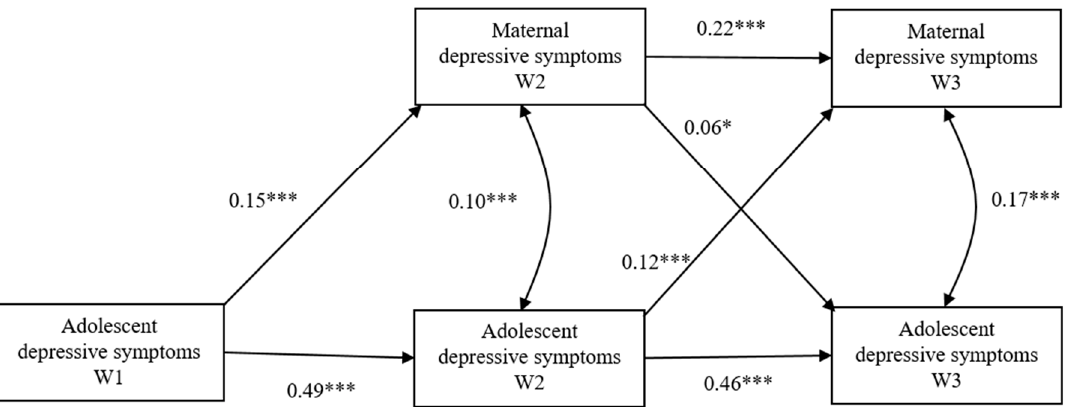
Figure 1. The cross-lagged model for maternal depressive symptoms and adolescent depressive symptoms. * p < 0.05, *** p < 0.001.